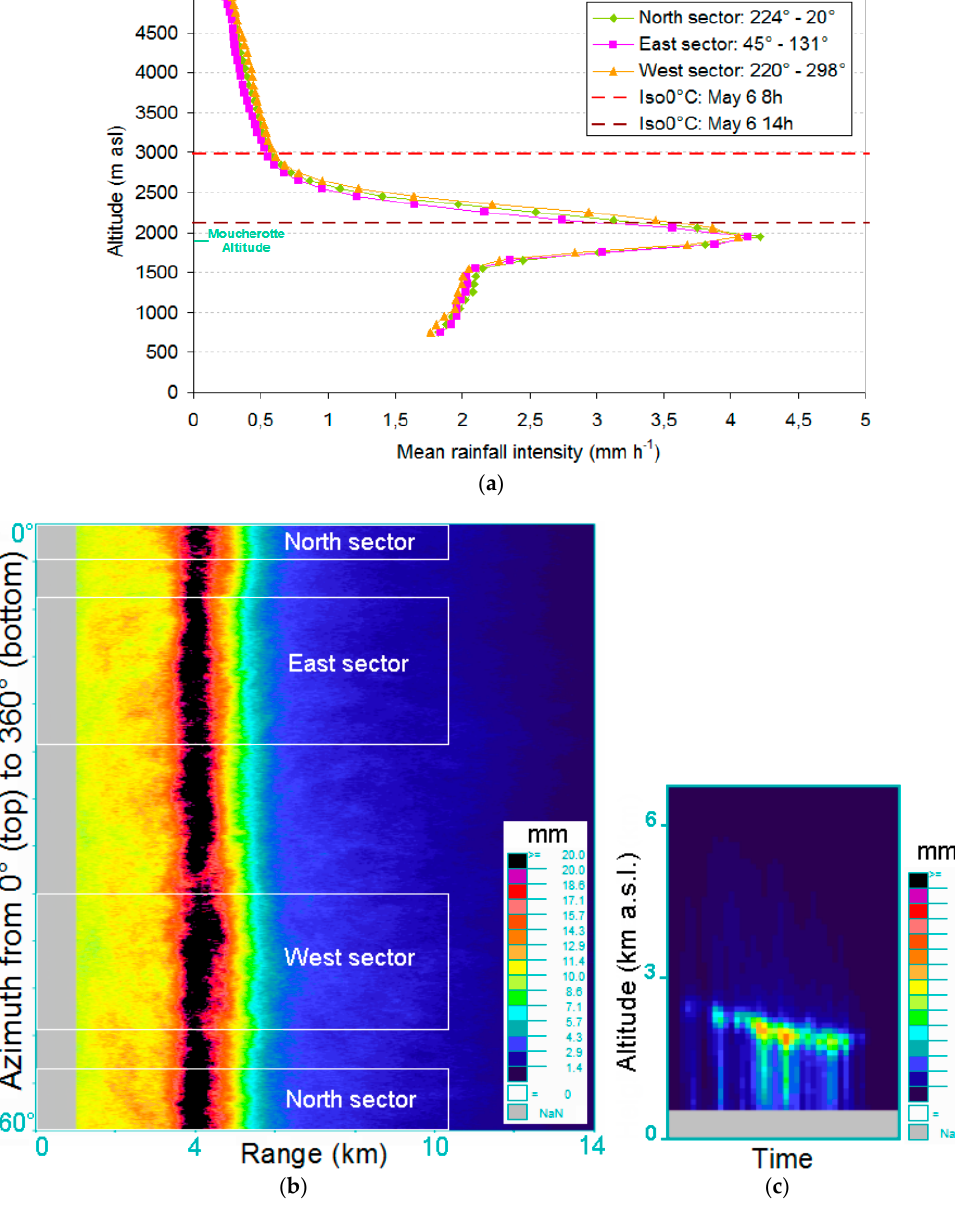
Figure 7. Example of mean apparent vertical profiles with spatially homogeneous precipitation in the valleys (May 06, 2017, from 8 h to 14 h UTC). ( a ) Mean vertical profiles in three sectors (VP S profiles) at 25° elevation angle. Reflectivity Z values have been converted in intensities of precipitation R, with the relationship Z = 200 R 1.6 . Dashed lines: altitude of 0 °C isotherm from AROME numerical weather prediction model at the beginning and the end of the considered sequence; ( b ) total radar precipitation accumulation (in mm) by azimuth as a function of range. Data within the first 1.3 km range is not usable; and ( c ) VP T profiles: temporal evolution of the mean precipitation intensity in mm/h (all sectors combined).